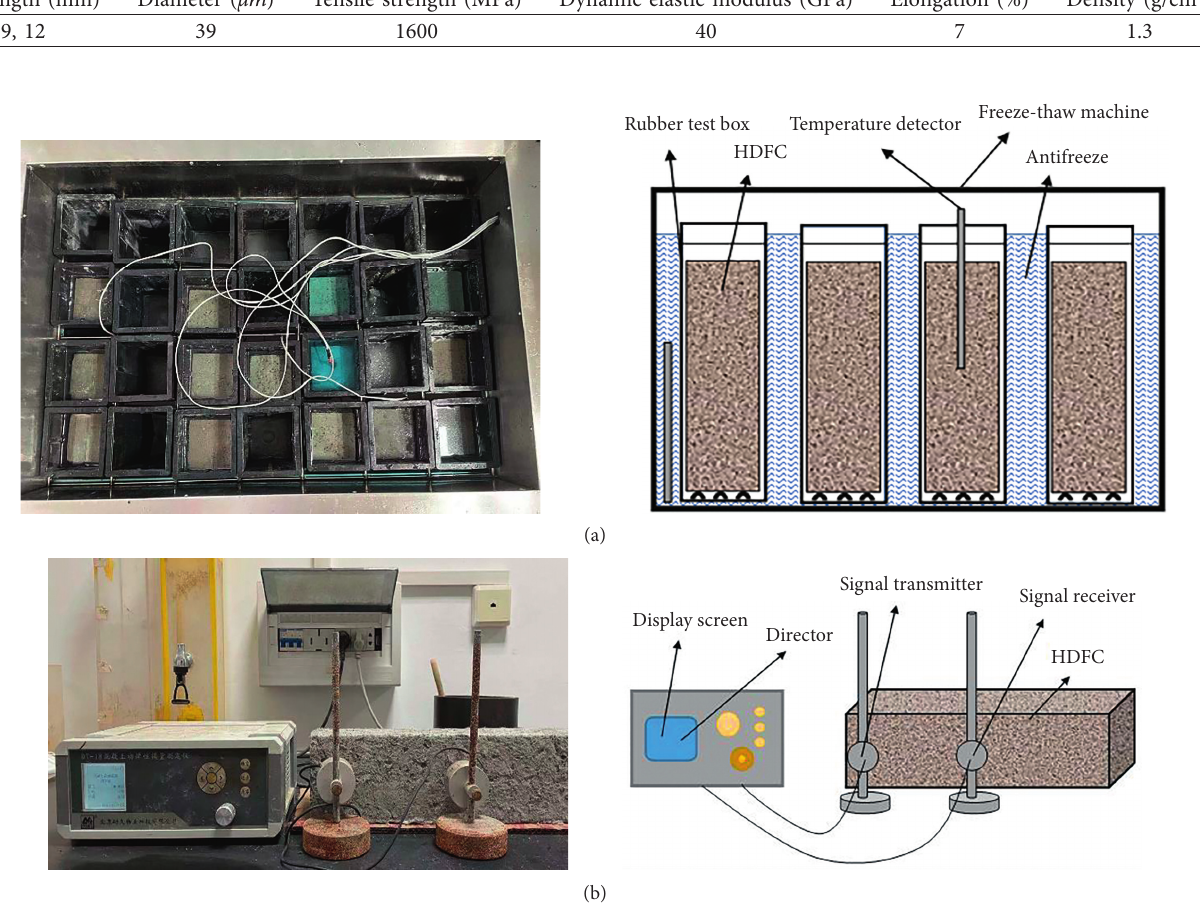
Figure 1: Test equipment diagram. (a) Freeze-thaw cycle machine. (b) Dynamic elastic modulus